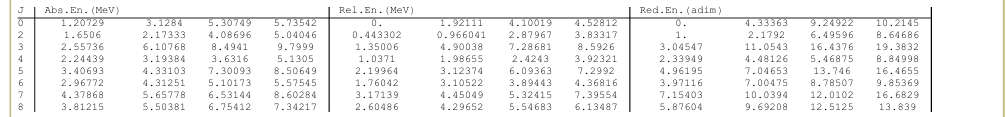
Figure 1. Output of the diagonalization routine for 128 Xe. The first panel shows absolute energies in MeV, the second shows energies relative to the ground state and the third shows reduced energies, i.e., the energies of the second panel normalized with the energy of the first 2 +